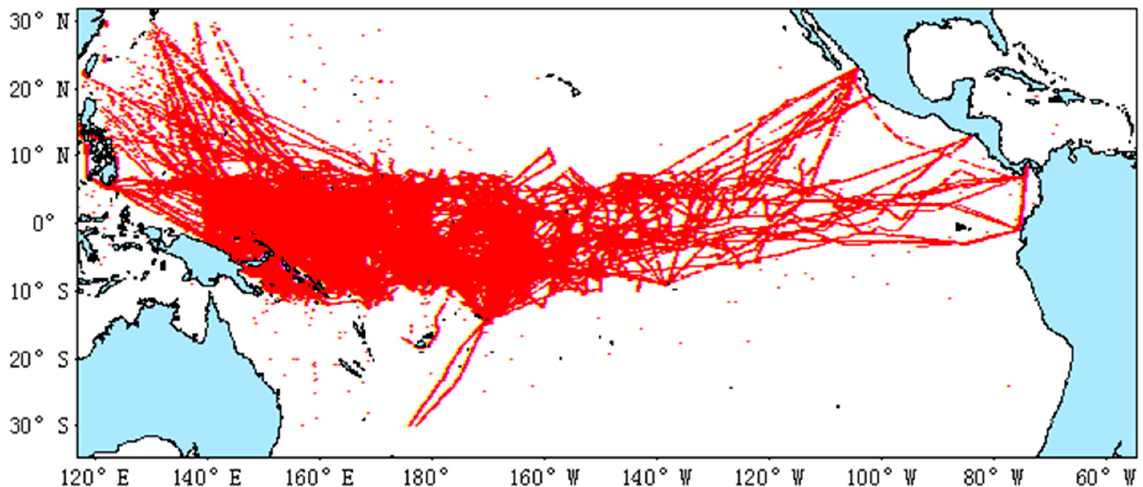
Figure 1. Study area: the spatial track points involved a total of 130 vessels (red area: the position of the vessels; blue area: the land).